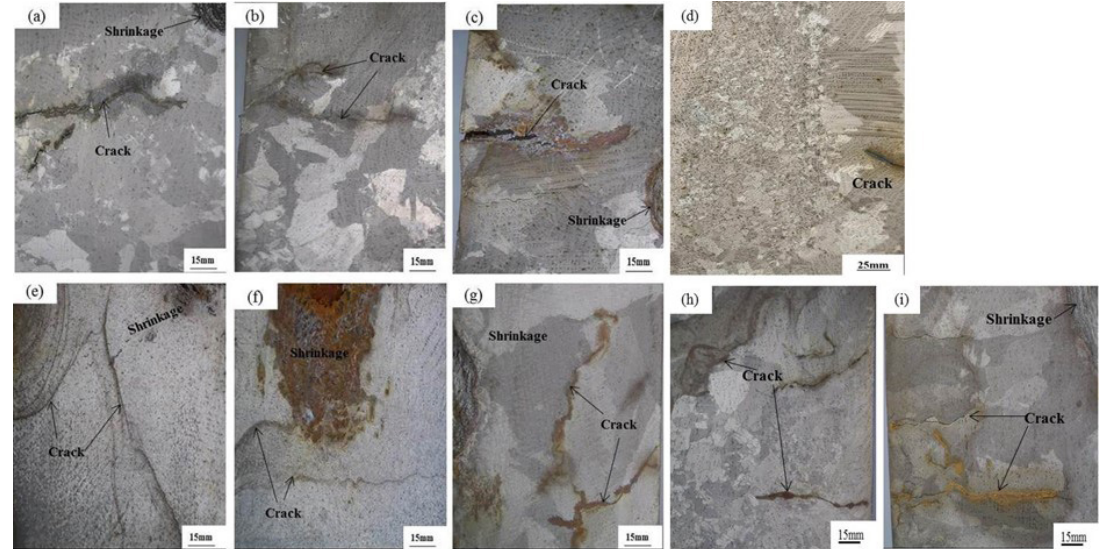
Figure 2. Micrographs of crack region at the centre of ingot, (a-d) With cooling time of 120s and SR of 1mm, 2mm, 3mm and 4mm, respectively; (e-h) With cooling time of 180s with SR of 1mm, 2mm, 3mm and 4mm, respectively and (i) Without